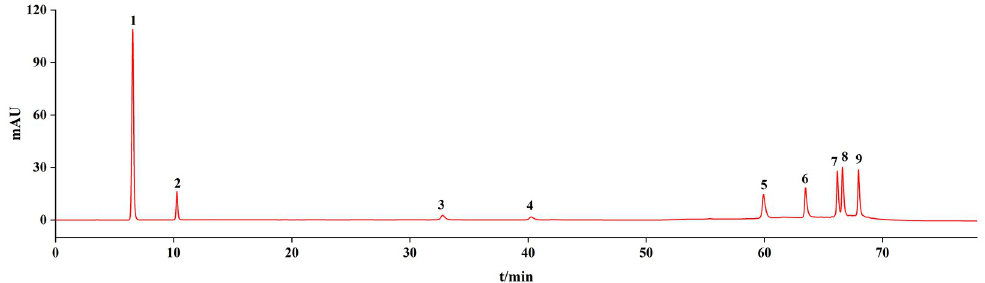
Fig 3. Chromatogram of pharmacopoeia standards. 1: Gallic acid, 2: (+) -catechin, 3: Sennoside B, 4: Sennoside A, 5: Aloe emodin, 6: Rhein, 7: Emodin, 8: Chrysophanol, 9: Emodin methyl ether.